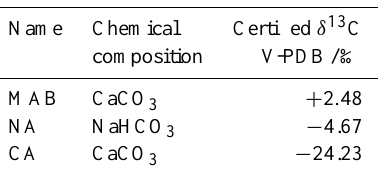
Table 2. The SUERC-ICSF in-house calibration standards. The cer- tified values in the final column are the values taken by C in Eq. (4). MAB, NA and CA are the names of the standards, and are not spe- cific abbreviations/acronyms.